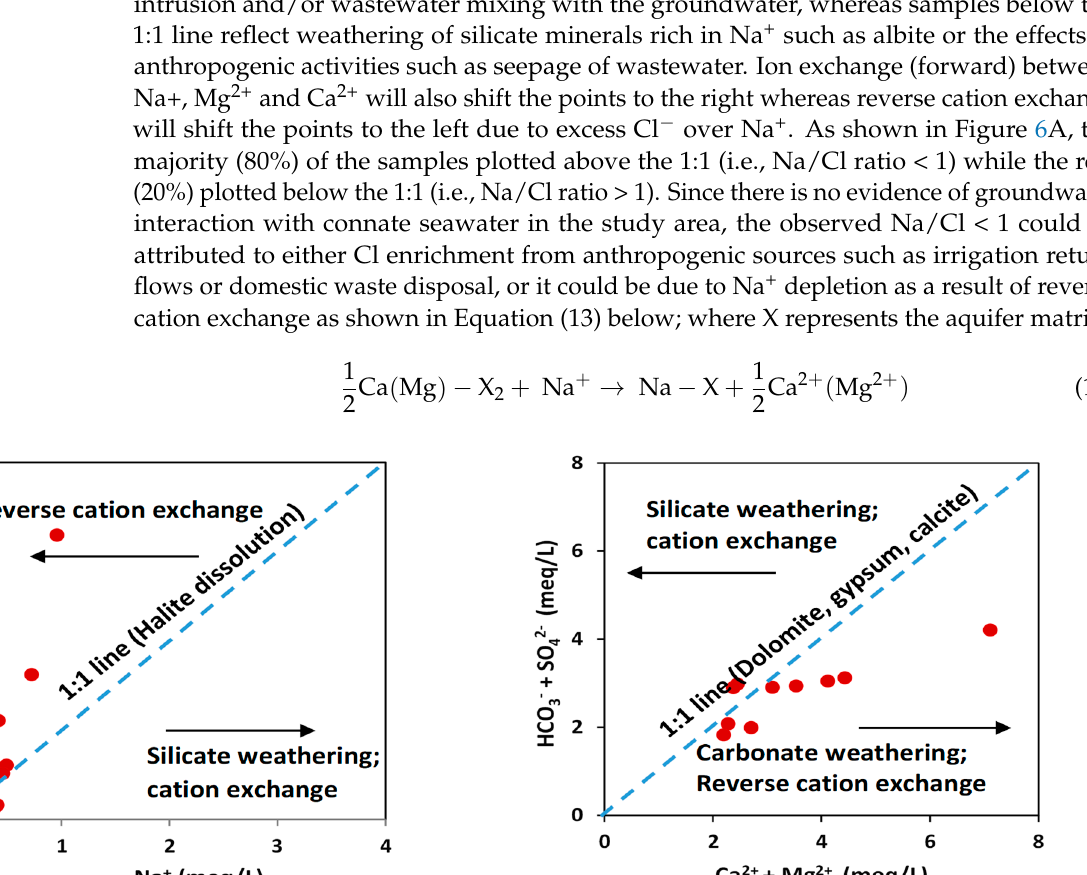
− ) versus (Ca 2+ + Mg 2+ 2- + HCO 4 3